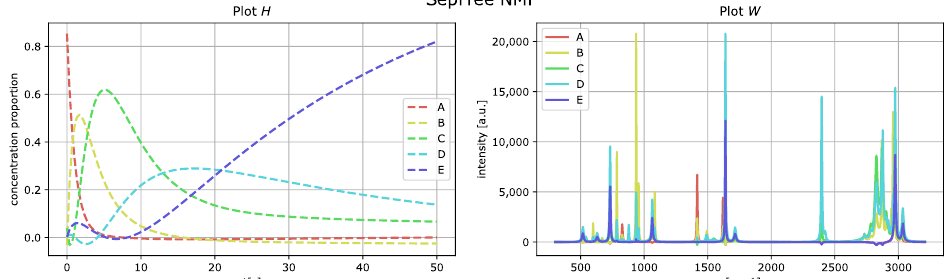
Figure 5. Reconstructed component-spectra of the compounds W on the right and reaction kinetics H on the for noiseless and 30% of increased peak interference of the synthetic Raman dataset. Paramater set [ − 0.001, − 10.0,1.0,0.0,0.0 ] . Minimal memory effect det ( S ) =